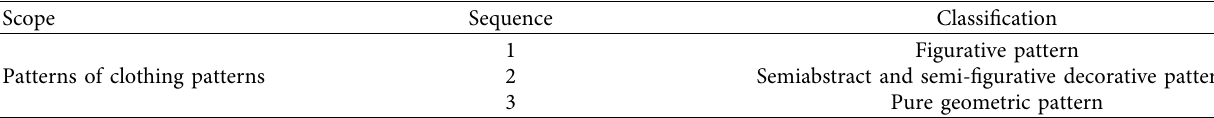
Figure 1: Illustration of ethnic dress patterns. Table 1: Classification of patterns of ethnic clothing patterns.